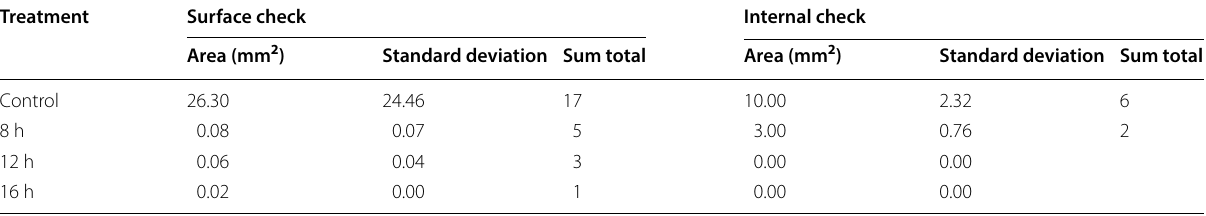
Table 2 Checks of larch timbers after drying